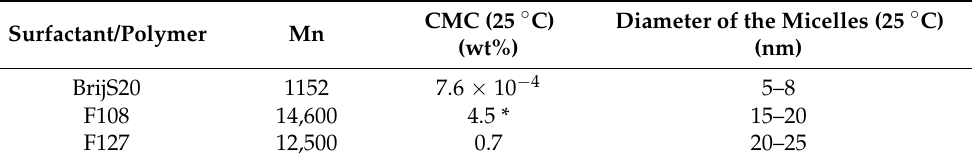
Table 1. Properties of BrijS20 and Pluronics triblock copolymers [25–30].